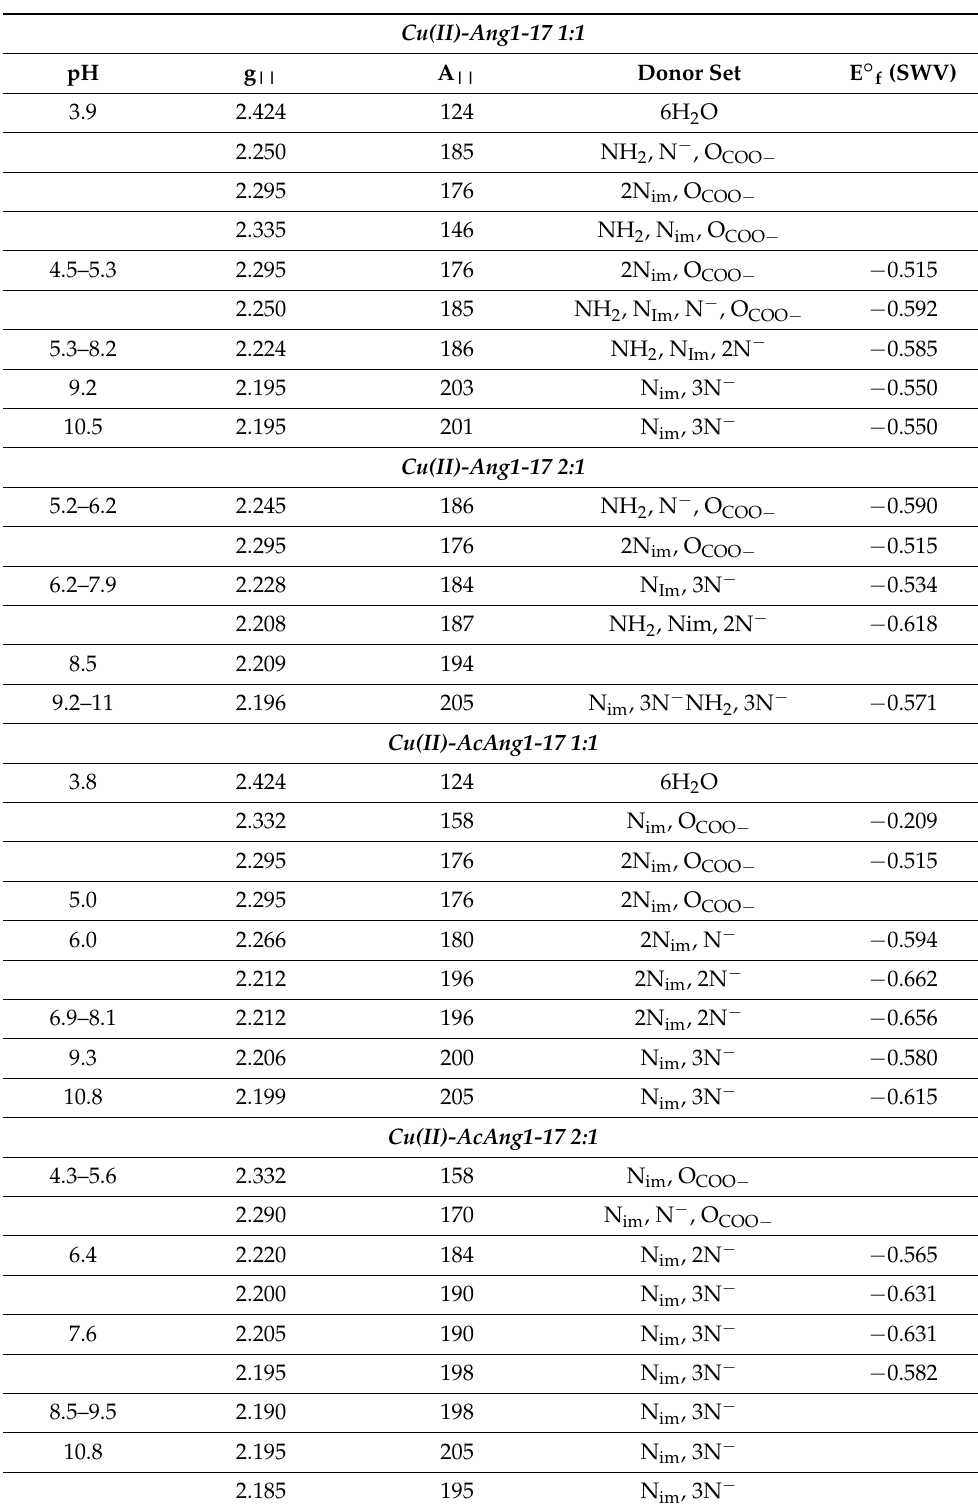
Table 3. ESR parallel Hamiltonian parameters and formal redox potentials of copper(II) with Ang1-17 and AcAng1-17 at different metal-to-ligand